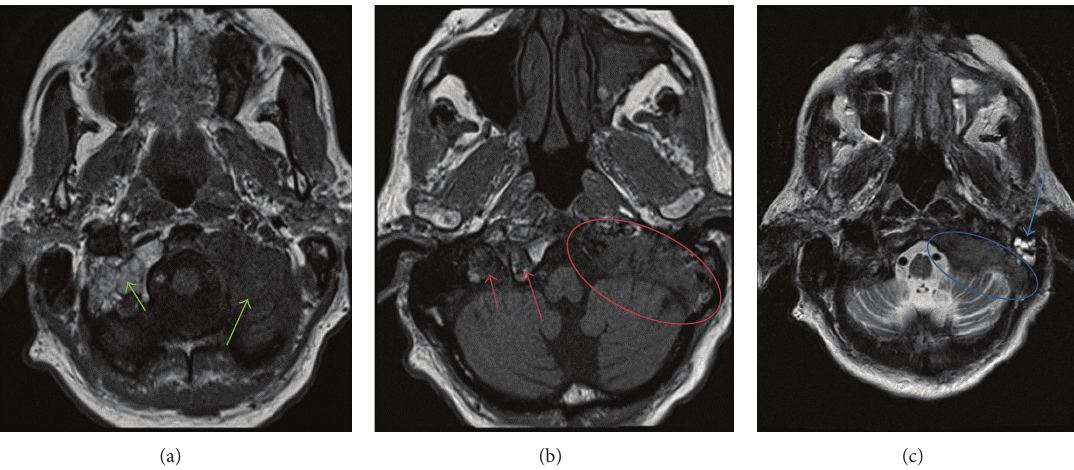
Figure 1: MRI scan of the head, 7/9/2014. (a) Axial T1 image shows a large posterior skull base mass. Note the normal bright fatty marrow (short green arrow) compared to darker signal from the mass (long green arrow). (b) Axial T1 image shows the mass (red oval) involving both the jugular foramen and the hypoglossal canal. Note the normal position of the contralateral jugular foramen (short red arrow) and the hypoglossal canal (long red arrow) for reference. (c) Axial T2 image shows involvement of the petrous temporal bone (blue oval) extending into the posterior inferior mastoid air cells, with bright reactive mastoid fluid (blue